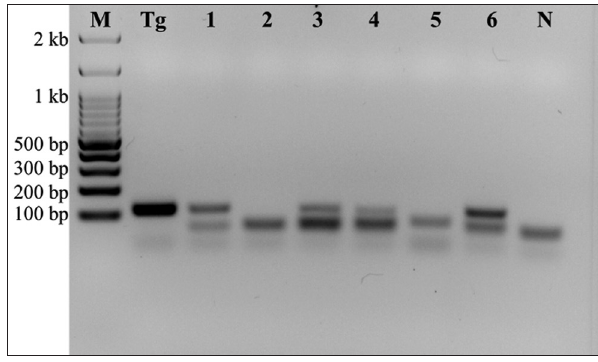
Figure-1: Representative B1 polymerase chain reaction products indicate the detection of Toxoplasma gondii from domestic cats in Phayao, Thailand. Lane M: 100 bp DNA ladder; lane Tg: Positive control (reference strain T. gondii ); lanes 1, 3–4, and 6: Positive T. gondii samples; lanes 2 and 5: Negative samples; lane N: Negative control ( Neospora caninum